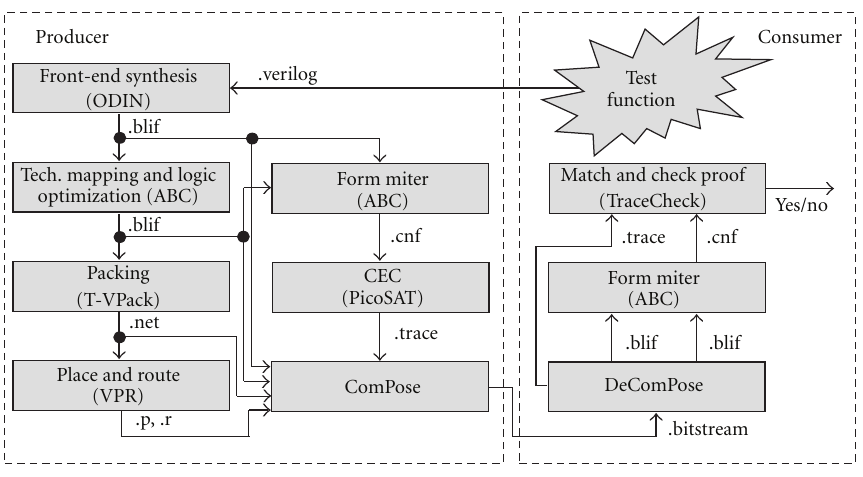
Figure 4: Runtime cec prototype tool flow. Table 4: Runtime comparison between PicoSAT (SAT) and TraceCheck (Check) for benchmarks of the 2008 SAT-Race TS 1. Size of cnf instance